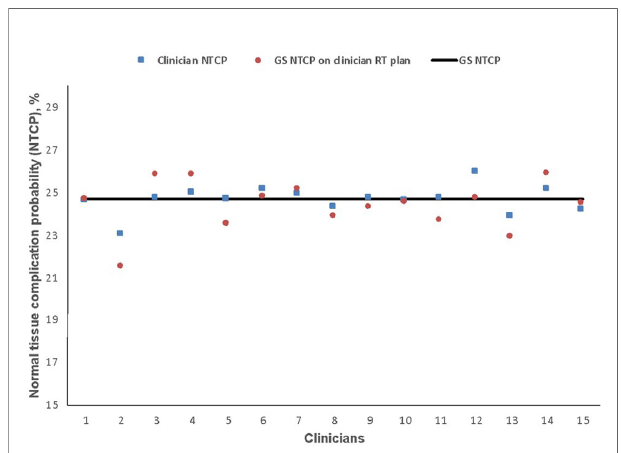
FIGURE 5 | Normal tissue complication probability (NTCP) values for physician-scored radiation-associated dysphagia at 6 months based on clinicians ’ dysphagia-optimized intensity-modulated radiotherapy (Do-IMRT) plans. The horizontal line represents the NTCP value for the gold standard (GS) Do-IMRT plan, based on GS pharyngeal constrictor muscle